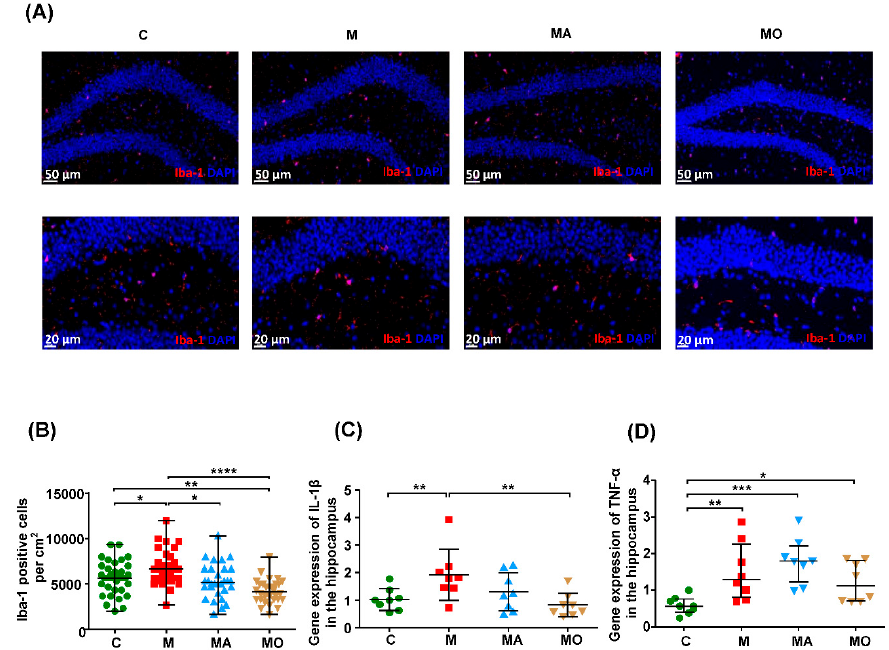
Figure 3. OCA supplementation ameliorated gut microbiota-mediated microgliosis in the hippocampus of HFHS diet mice. HFHS diet mice were characterized with increased microglial cells in the hippocampus and were reduced by ABX treatment. OCA supplementation significantly reversed the microgliosis and proinflammatory cytokines expression in the hippocampus of HFHS diet mice. ( A ) Representative immunofluorescence staining of microglia (Iba-1 positive cells) in the hippocampus. ( B ) Density of Iba-1 positive cells in the hippocampus. ( C , D ) The gene expression of proinflammatory IL-1 β and TNF- α in the hippocampus. n : ( A – D ) 5–8 per group. Note: data are given as mean ± SEM. * p < 0.05; ** p < 0.01; *** p < 0.001; **** p < 0.0001. Groups: C, mice with normal chow; M, mice with HFHS diet; MA, ABX-treated HFHS diet mice; MO, OCA-treated HFHS diet mice. Abbreviations: HFHS, high-fat high-sugar; qRT–PCR, quantitative real-time polymerase chain reaction; SEM, standard error of the mean; OCA, obeticholic acid; ABX,